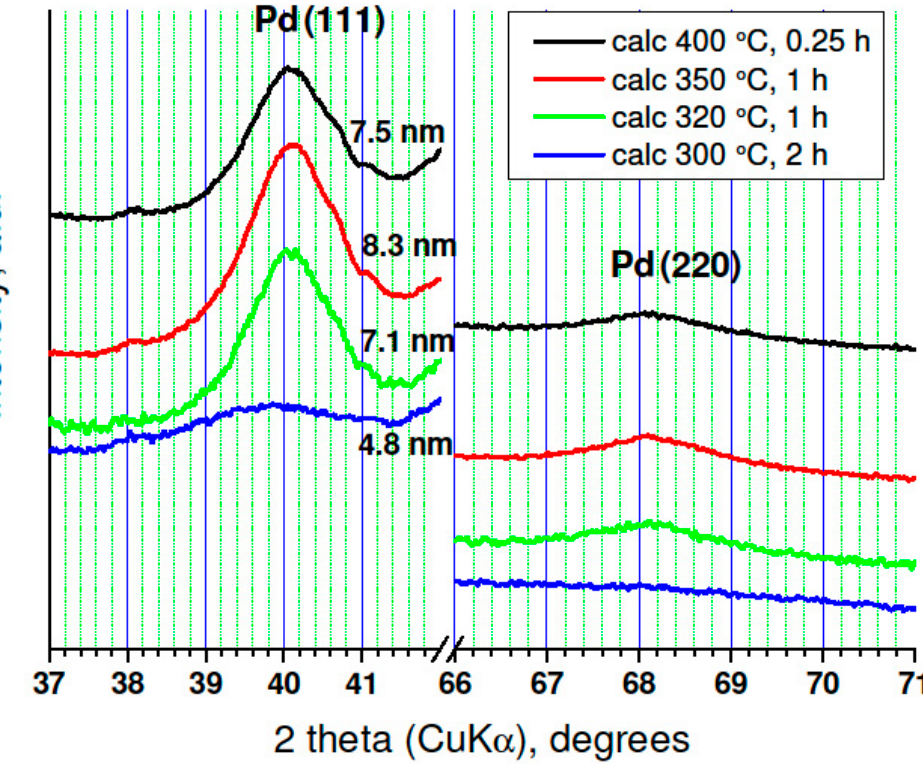
Figure 3. XRD profiles of 2 wt % Pd/Norit1600 catalysts precalcined at different temperatures and reduced at 400 °C for 1 h. Pd crystallite size was determined from the (111) XRD line broadening using the Scherrer formula.